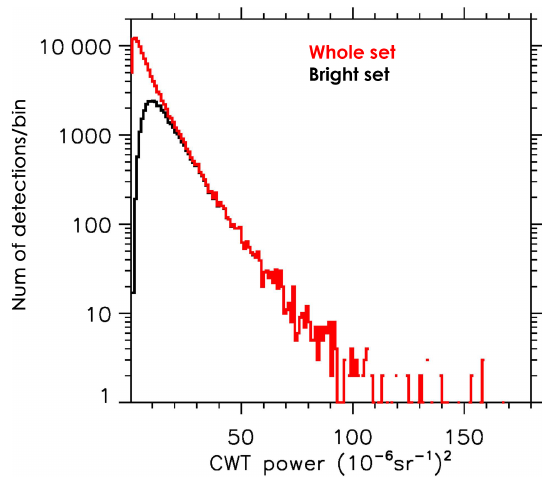
Figure 3. The histograms of the CWT power values obtained throughout the two northern hemispheric summers in 2007 and 2010. Each CWT power value refers to an average within a given elliptical region. The black curve is for the brighter cloud group that corresponds to freq 25 > 2% within a given elliptical region, and the red curve is for the full set of detections. The bin size within which we count the detection number is 1 . 0 × 10 − 12 sr − 2